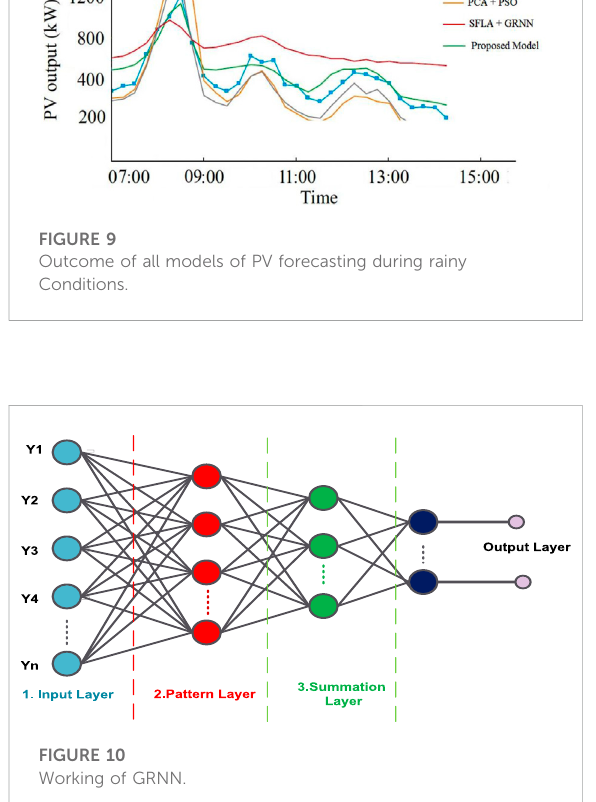
FIGURE 10 Working of GRNN.